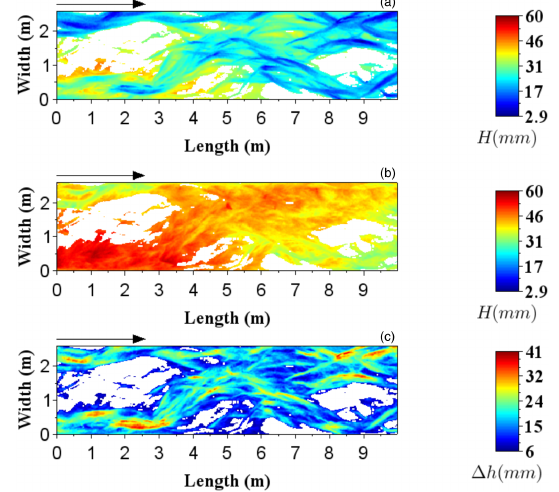
Figure 3. The minimum surface, the maximum surface and the morphological active layer. The minimum surface (a) is defined at the lowest elevation for each location throughout 40h. The maxi- mum surface (b) is the highest elevation for each location through- out 40h. The morphological active layer (c) is the difference be- tween the maximum surface (b) and the minimum surface (a) . Whites parts are the no-change areas. The arrow indicates flow di- rection, and the flume slope is removed.